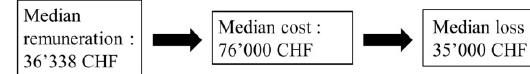
Figure 6. Comparison between costs and revenues.